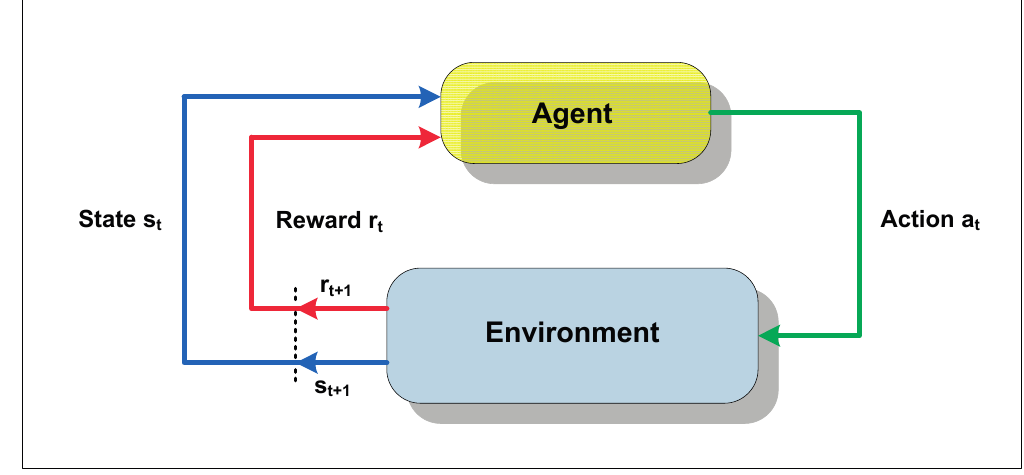
Figure 2. Scheme of interaction between the agent and